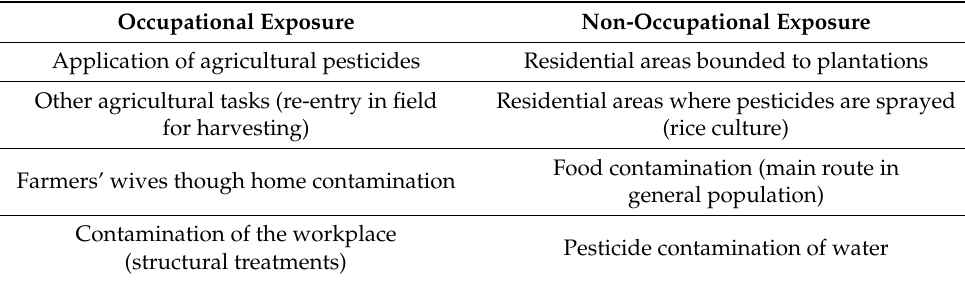
Table 3. Sources of exposure to pesticides in